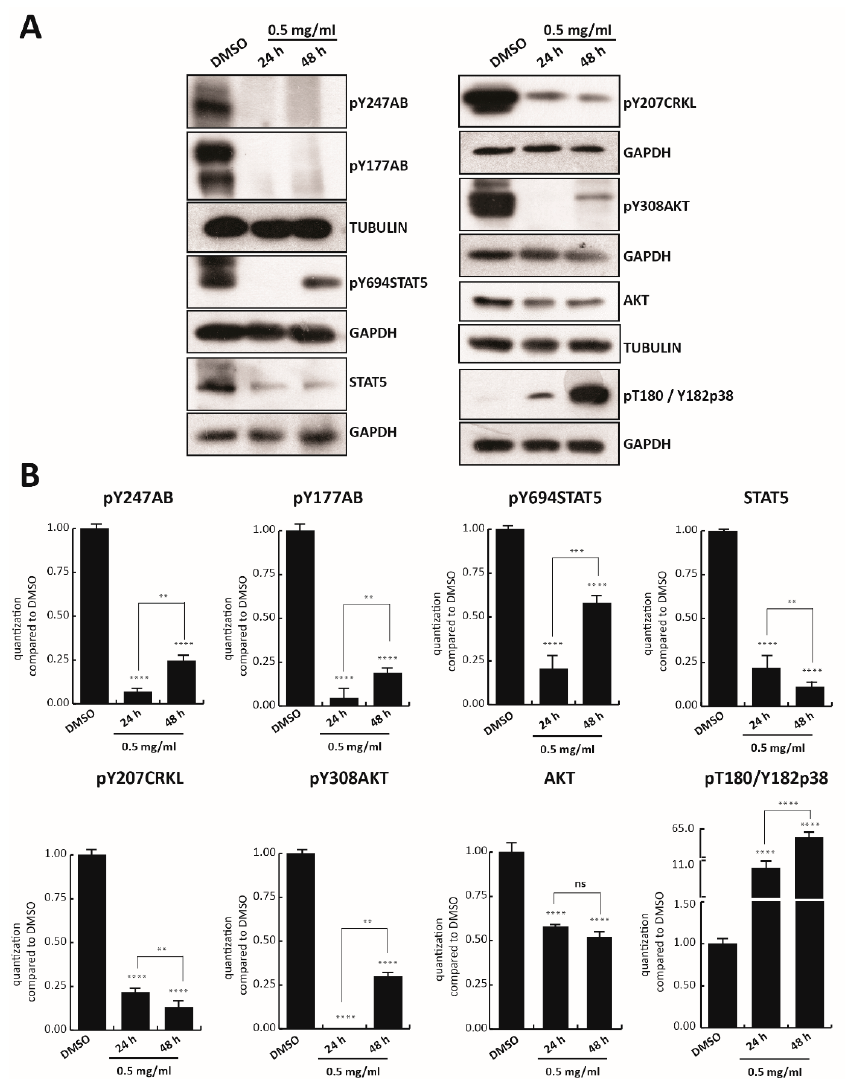
Figure 2. TR inhibits BCR-ABL/STAT5 signaling pathway. ( A ) Western blot analysis of pY247AB, pY177AB, pY694STAT5, STAT5, pY207CRKL, pY308AKT, AKT, and pT180/Y182p38. K562 cells were pY177AB, pY694STAT5, STAT5, pY207CRKL, pY308AKT, AKT, and pT180 / Y182p38. K562 cells